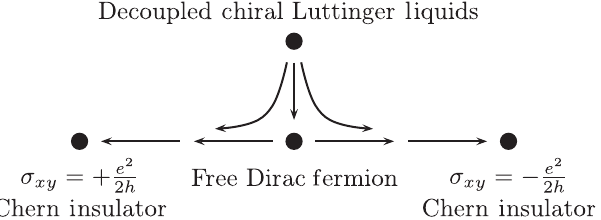
FIG. 7. Schematic RG flow for the array of counterpropagating chiral wires, viewed as arising on the surface of a 3D topological insulator. Systems that preserve the time-reversal symmetry defined in Eq. (50) are confined to the separatrix and flow to the free-Dirac-fermion fixed